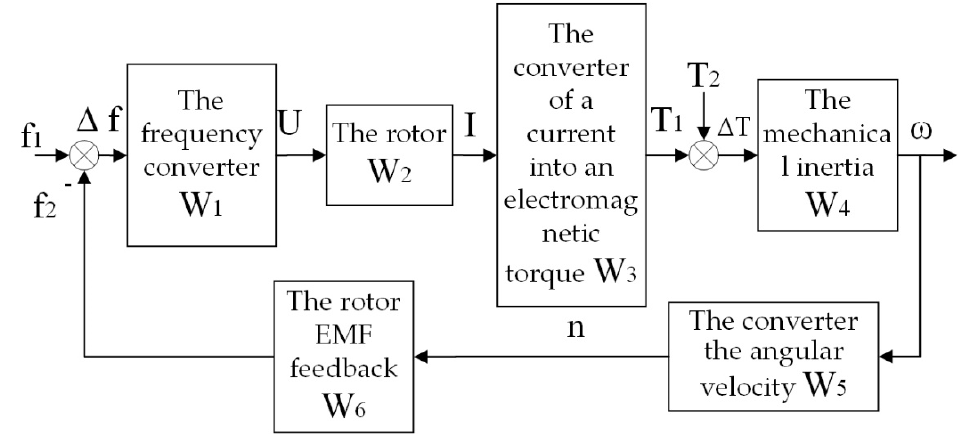
Figure 3. Structural model of FC-IM: ω is an angular velocity of the actuator, rad/s; n is a motor speed, rpm; f 2 is a frequency, Hz, equivalent to motor speed; f 1 is a stator winding voltage frequency, Hz; U is a stator winding voltage, V; I is rotor current induced to stator winding; T 1 is an electromagnetic torque created by the rotor of motor, N · m; T 2 is a moment of load, N · m.